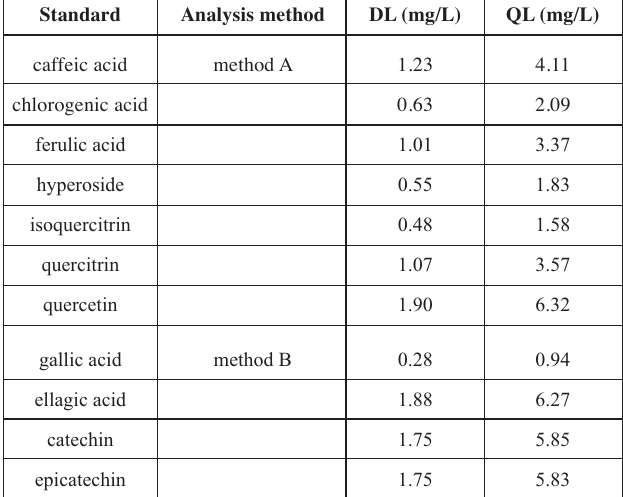
acid, were purchased from Sigma Aldrich (USA) and Fluka Biochemika (Switzerland) respectively; potassium dihydrogen phosphate was also purchased from Sigma Aldrich